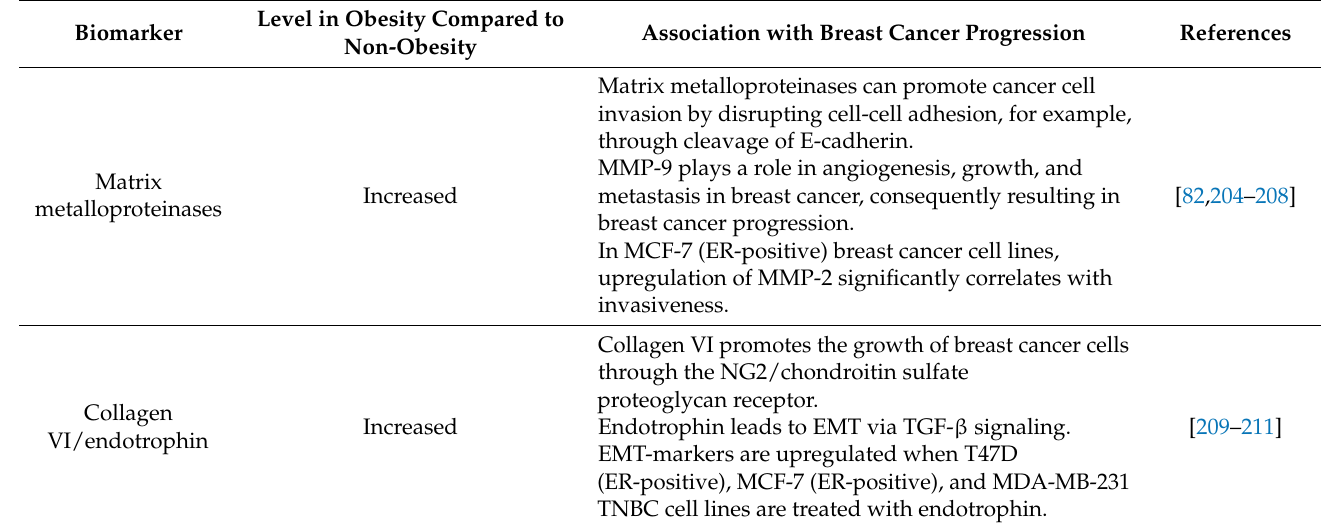
Table 4. Local obesity-associated biomarkers in ECM remodeling involved in breast cancer